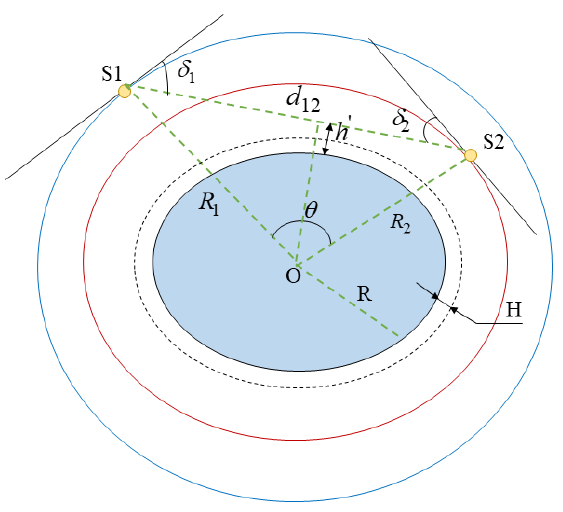
Figure 5. Establishment of instantaneous LISLs between different orbits. The altitude of the LISLs established by the two satellites above the surface h (cid:48) is shown in Equation